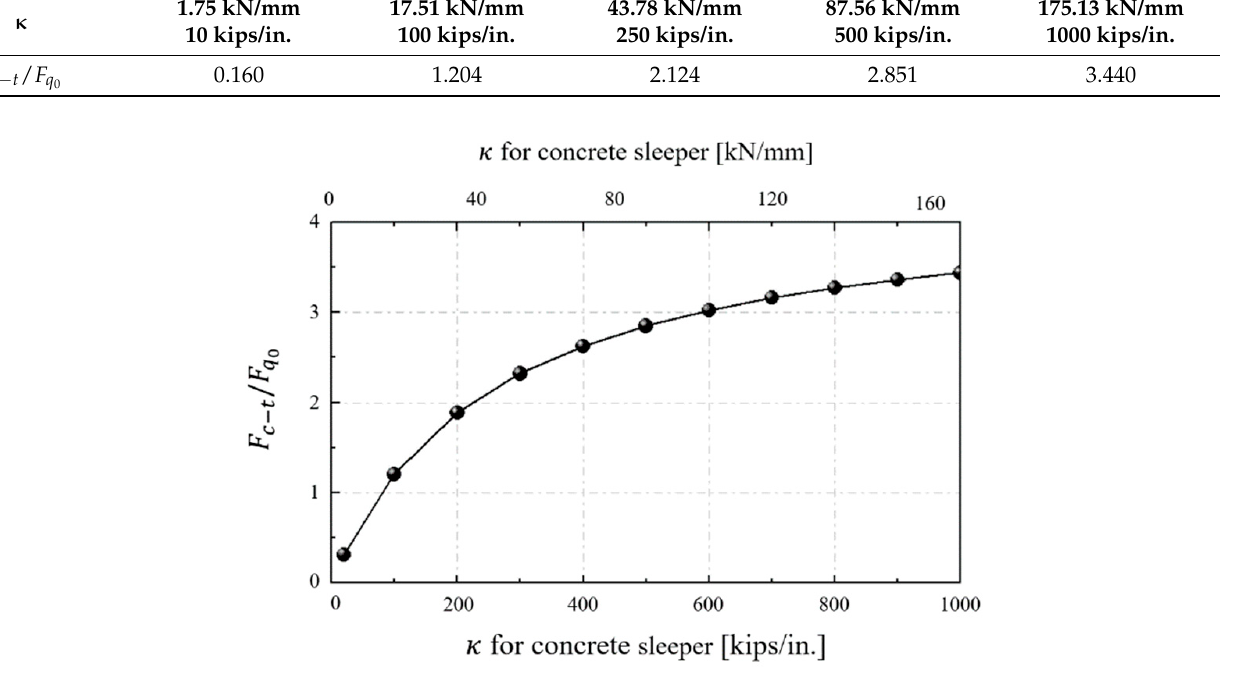
Figure 4. The result of 𝐹